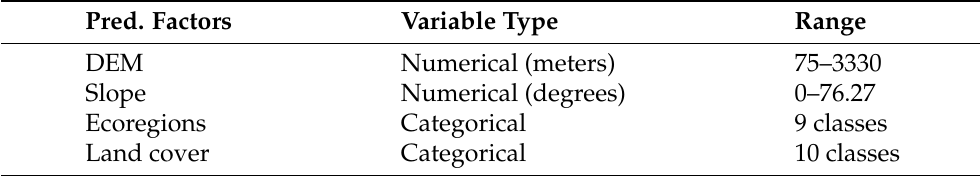
Table 1. Summary of predisposing factors and their